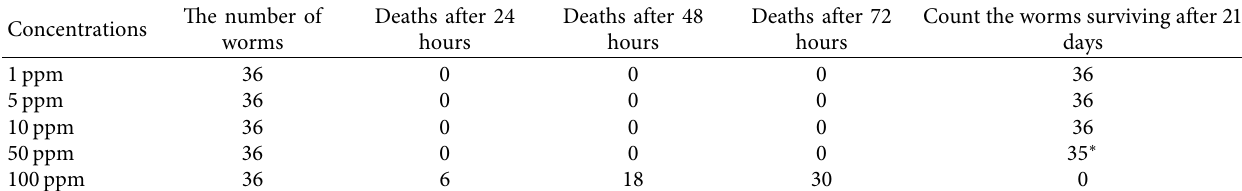
Table 1: Number of worm deaths exposed to different concentrations of mercury chloride (HgCl2). The number of Concentrations worms